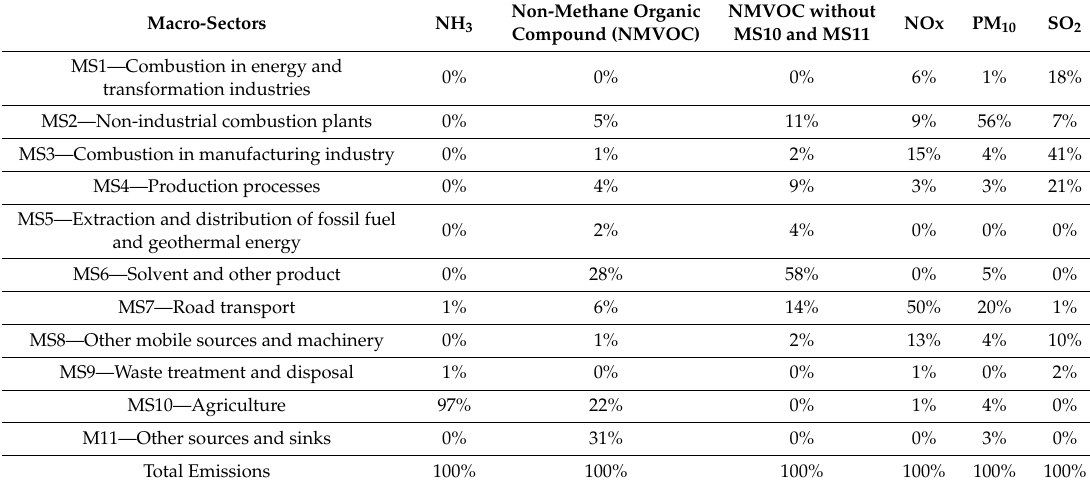
Table 1. Emissions for PoValley, baseline